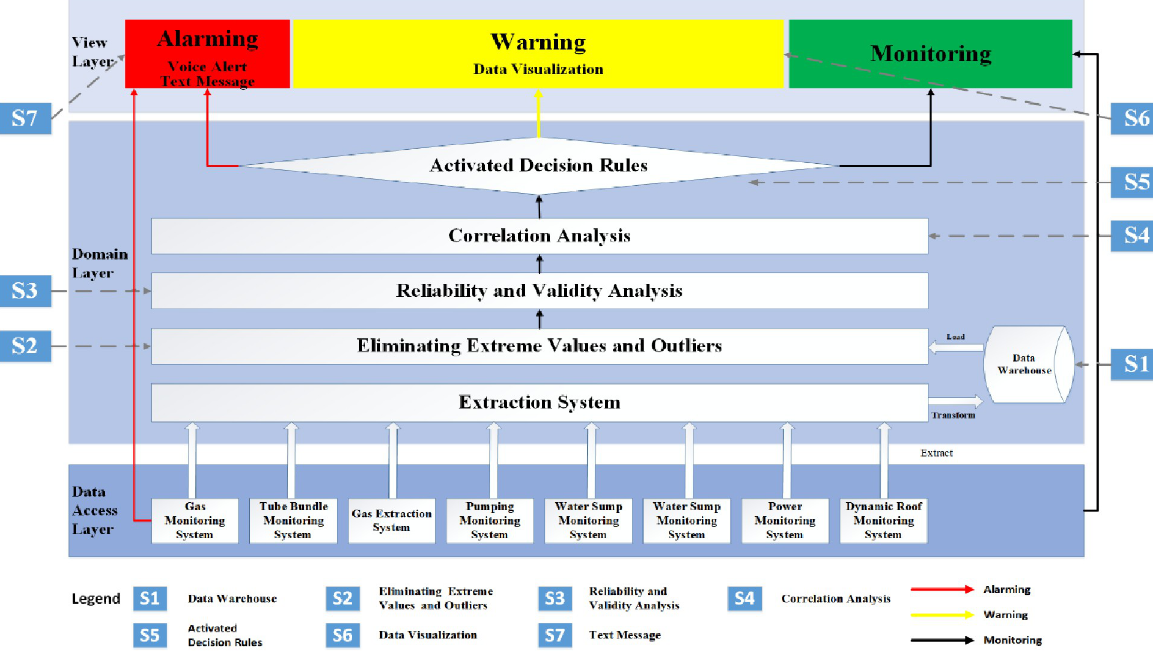
Fig 3. A three-layer architecture for demonstrating the proposed